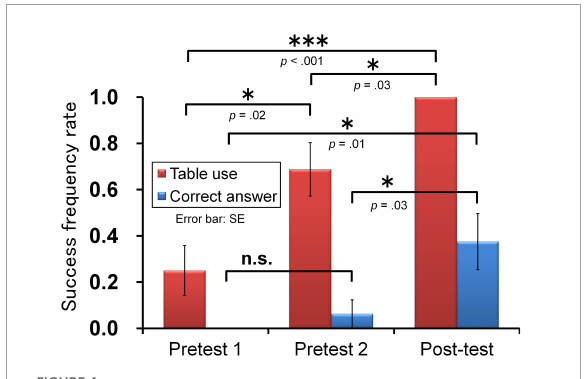
FIGURE5 Changes in cerebral blood flow. The numbers on the figure are t values for changes in the average cerebral blood flow concentration per unit time between test phases; (A) Pretest 2—Pretest 1; (B) Post-test—Pretest 2; (C) Post-test—Pretest 1; (R) right, (L) left; N = 16. ROIs are circled. Upper left circle, right DLPFC (3 ch.); upper right circle, left DLPFC (6 ch.); lower left circle, right VLPFC (36 ch.); lower right circle, left VLPFC (41 ch.) (see Figure 2 ).